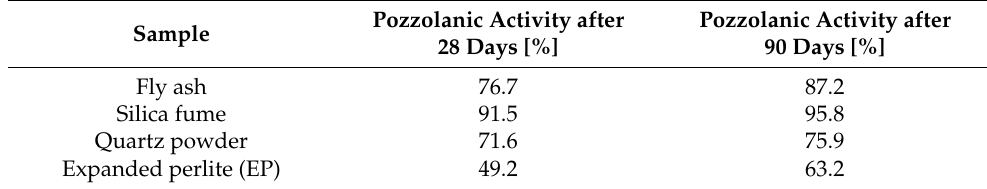
Table 6. Pozzolanic activity of mineral